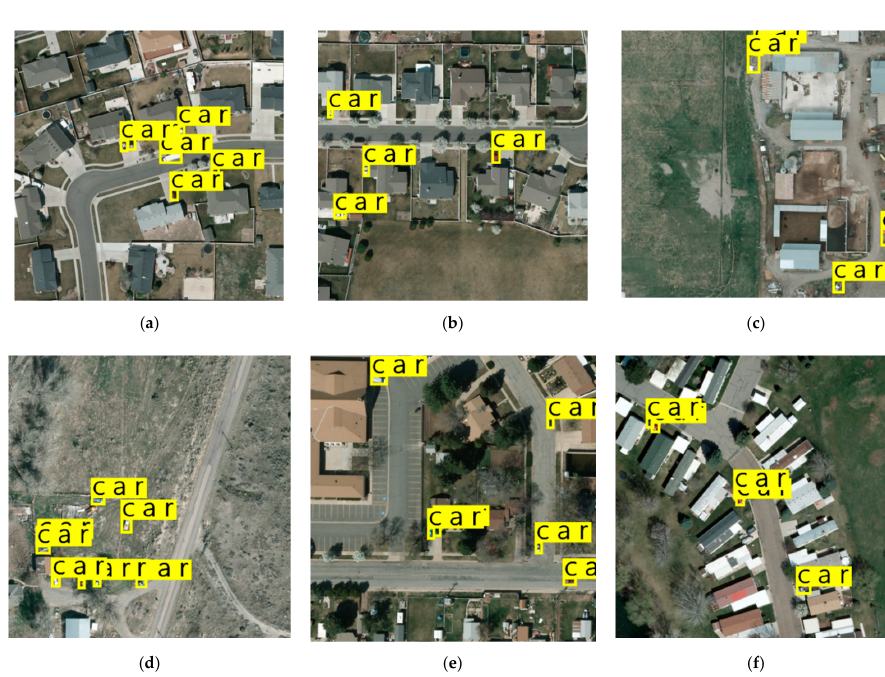
Figure 16. The detection results with the VIDEA dataset.